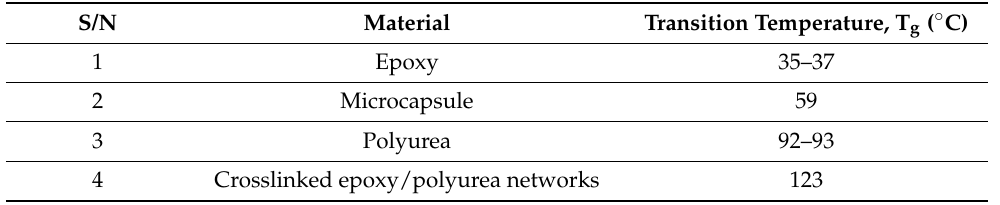
Figure 9. ( A ): Gaussian fitting of log (tan( ∂ )) of epoxy filled with microcapsules synthesized using a water:oil ratio of 5.5:1 (step 1). Peak due to: (a) epoxy; (b) microcapsule; (c) PU/epoxy interaction. ( B ) Gaussian fitting of log (tan( ∂ )) of epoxy filled with microcapsules synthesized using a water:oil ratio of 5.5:1 (step 2). Peak due to: (c) PU/Epoxy interaction; (d) unreacted HDI. ( C ): Gaussian fitting of log (tan( ∂ )) of epoxy filled with microcapsules synthesized using a water:oil ratio of 5.5:1 (step 3). Peak due to: (c) PU/epoxy interaction. Table 1. Thermal transition temperature of materials.